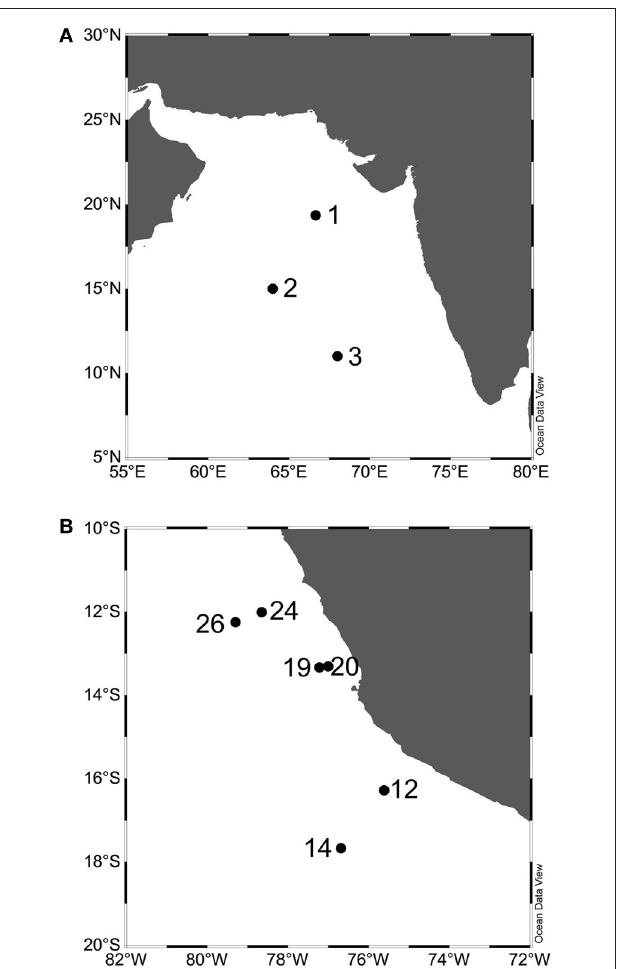
FIGURE 1 | Stations in the Arabian Sea (A) and the Eastern Tropical south Pacific (B). Maps were made using Ocean Data View (Schlitzer,